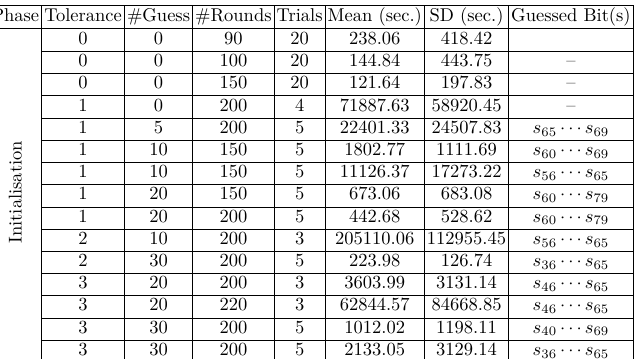
Table 7: Results for TRIVIUM on HD